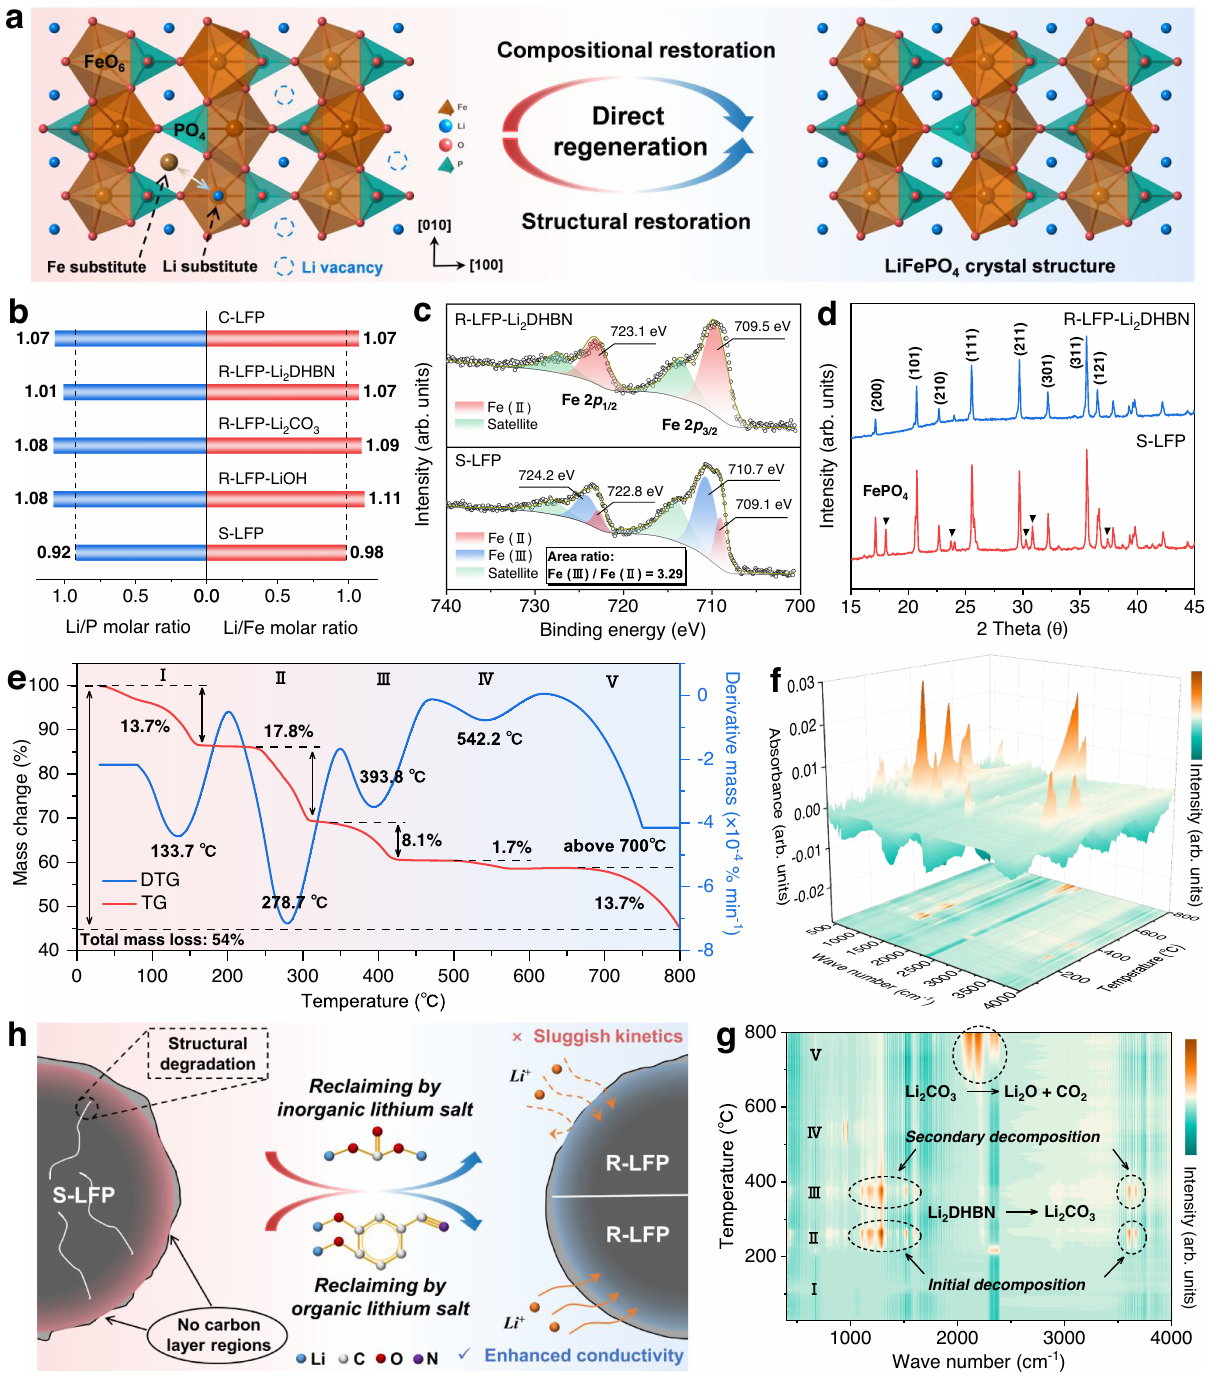
Fig. 1 | Degradation mechanism and regeneration process of LFP cathodes. a Schematicofthedegradedandrestoredcrystalstructures. b Li/PandLi/Femolar ratio based on ICP-OES. c Fe 2 p XPS spectrum of S-LFP and R-LFP-Li 2 DHBN. d XRD